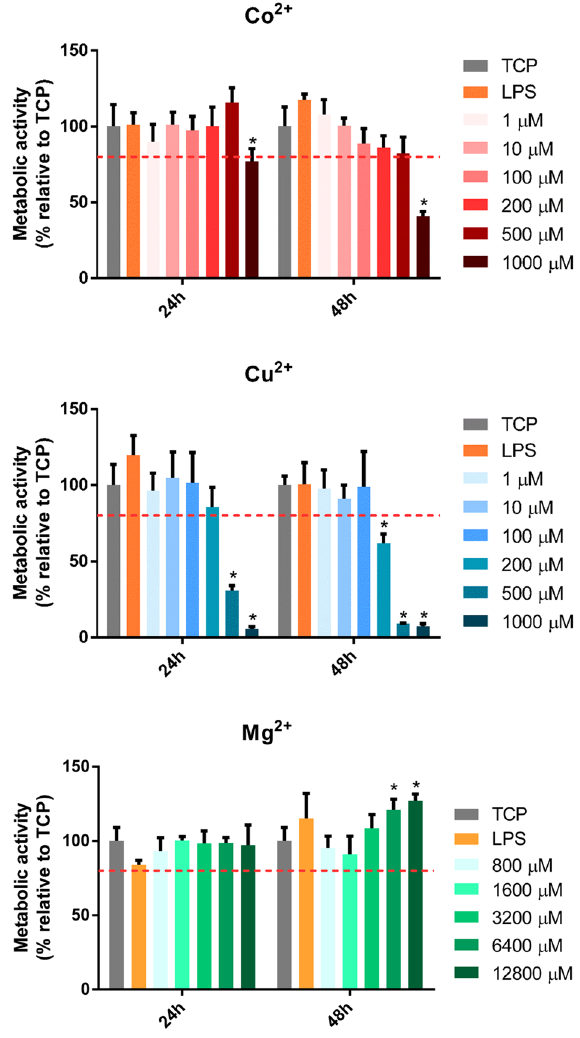
Figure 1. Effect of Co 2+ , Cu 2+ and Mg 2+ ions on THP-1 cell metabolic activity. Metabolic activity of THP-1 cells cultured with different Co 2+ , Cu 2+ and Mg 2+ concentrations for 24 and 48 h. Metabolic activity results were represented as percentage relative to an unstimulated control (TCP) and compared with the TCP of each day. Values lower than 80% metabolic activity (red line) which were significantly different ( p < 0.05) from TCP were considered cytotoxic. Statistically significant differences ( p < 0.05) were represented with